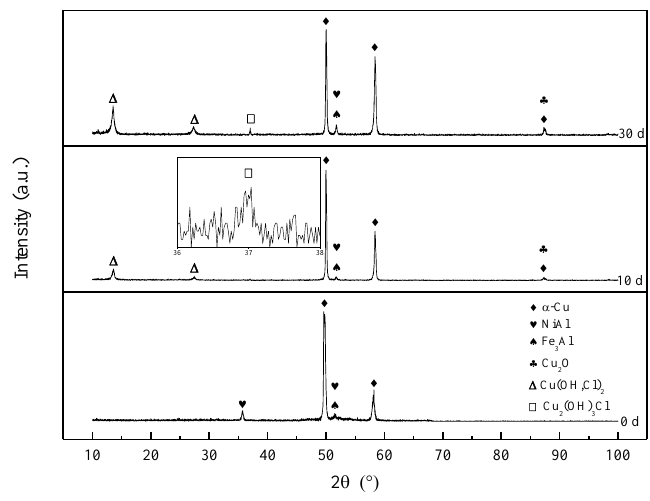
Figure 8. The XRD patterns of S-Defect immersed for different time periods in artificial seawater.